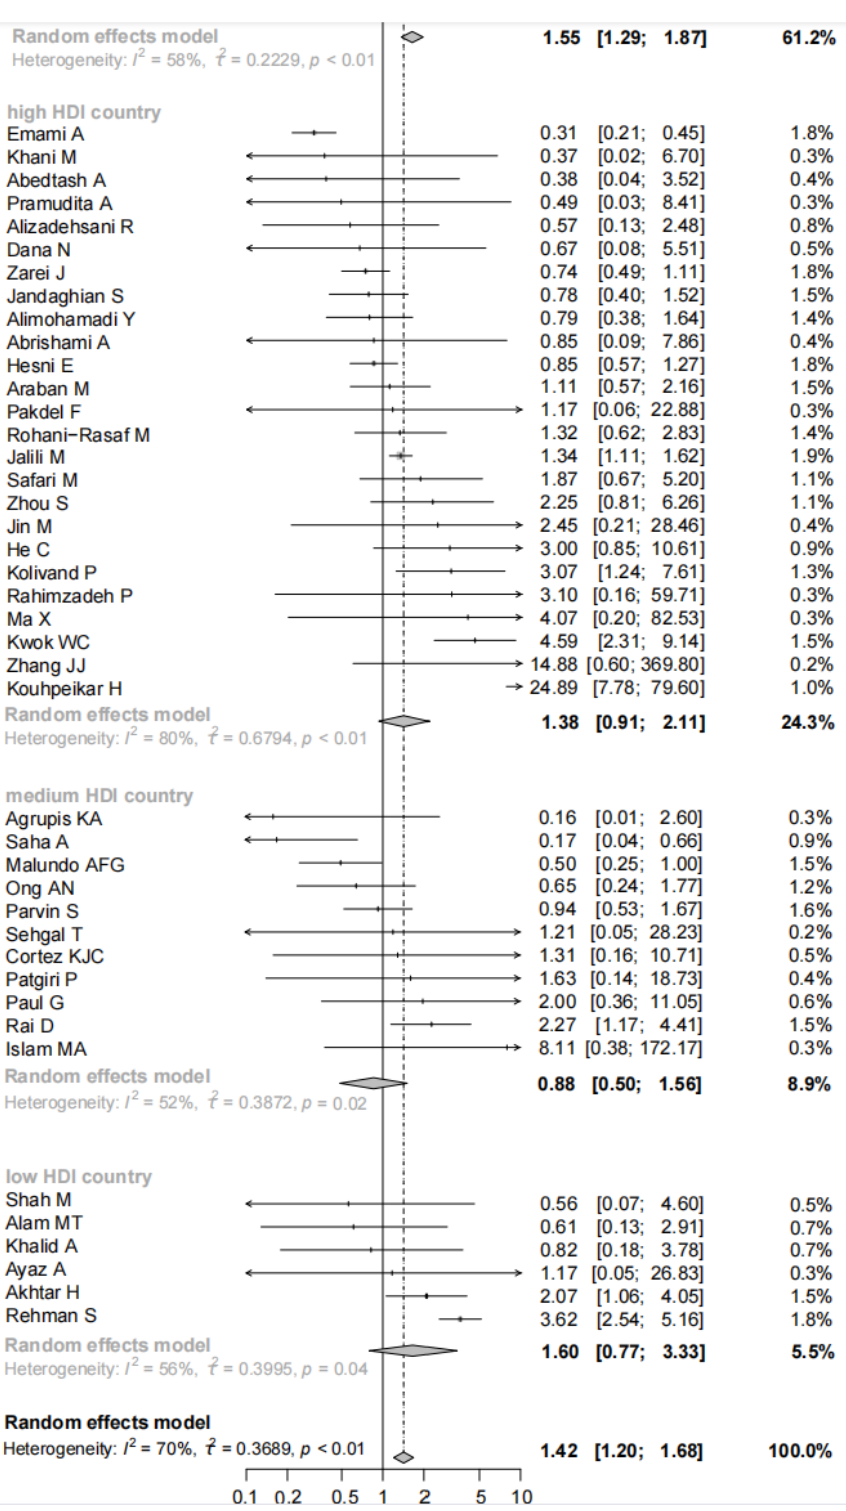
Figure 2. Forest plot indicated there was a significant association between comorbid asthma and the increased risk for mortality of COVID-19 patients in Asia.